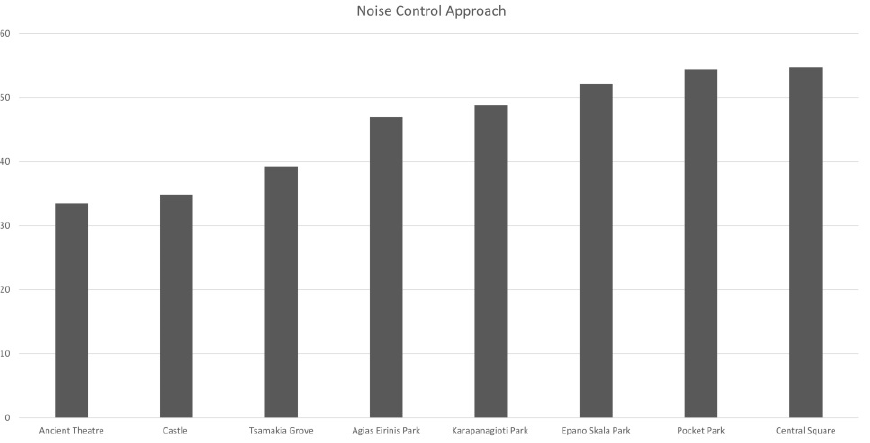
Figure 6. Potential quiet areas ranked using the noise control approach. Finally, the noise map that was created using the cadnaA software is presented in Figure 7.